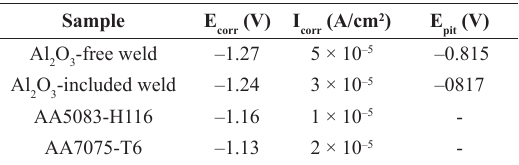
Figure 8. Polarization curves obtained from the SZ of Al and Al O -included specimens. 2 3 Table 3. Corrosion potentials and exchange current densities of FSWed joints and primary alloys. Sample